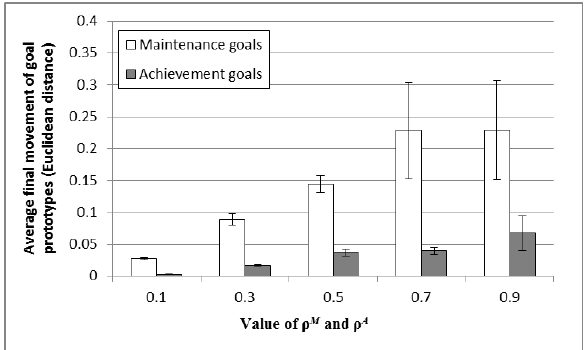
Figure 13: Expt 2: Impact of non-linear distance metric and ρ M and ρ A on convergence of cluster prototypes.